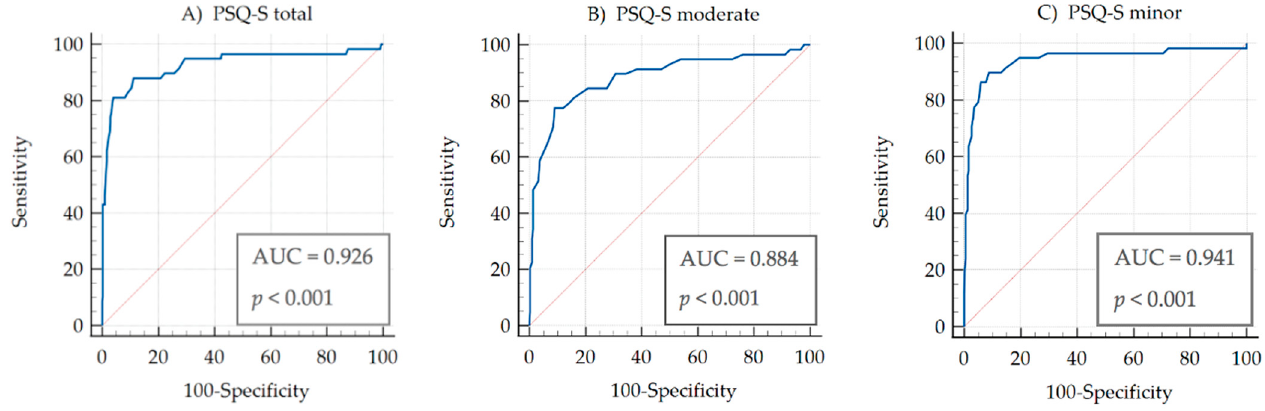
Figure 2. The capacity of PSQ-S to discriminate between the sensitivity of chronic pain patients and healthy controls: cut-off points and their predictive values. Table 6. ROC curve analysis data of the PSQ ‐ S.